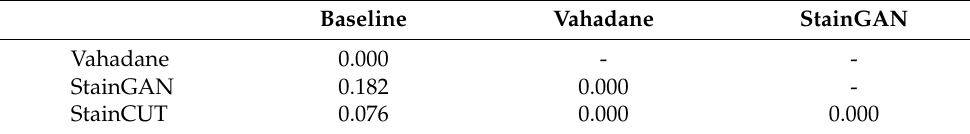
Table A11. p -values obtained from the Nemenyi test applied to the UMCU with Setting (2). Baseline